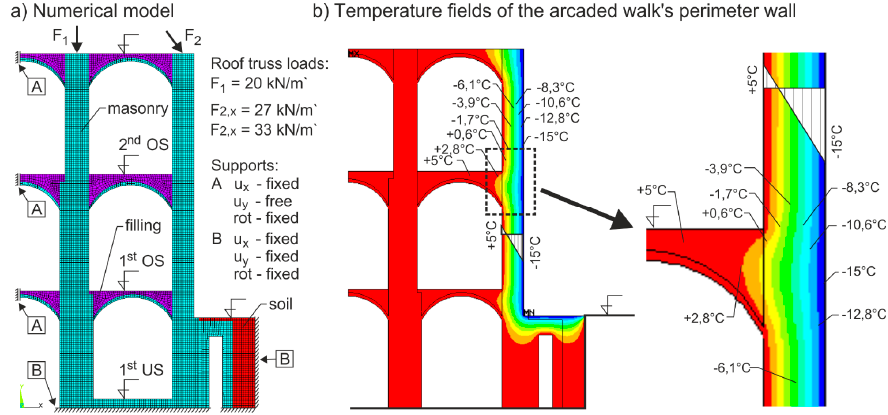
Figure 5. ( a ) Numerical model and ( b ) Finite element method (FEM) analysis of temperature fields of the arcaded walk’s perimeter wall. Force F2, representing the roof truss action, has a horizontal component as the functional capacity of the connection between the tie beam and masonry could not be verified, i.e. , potential displacement in the “masonry–tie beam” was considered, which more likely corresponds to the actual state of the historic roof truss.